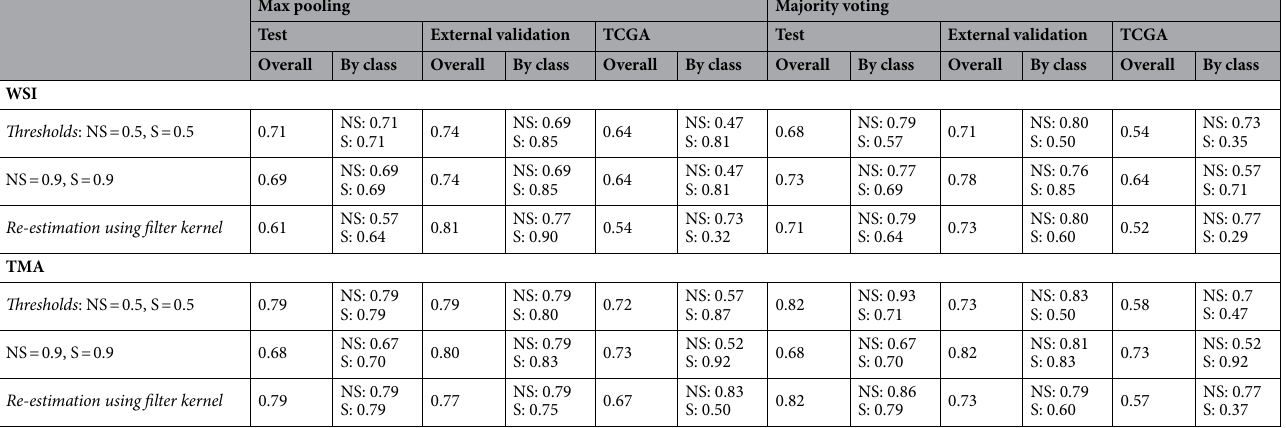
Table 3. Accuracy achieved by the different strategies at patient